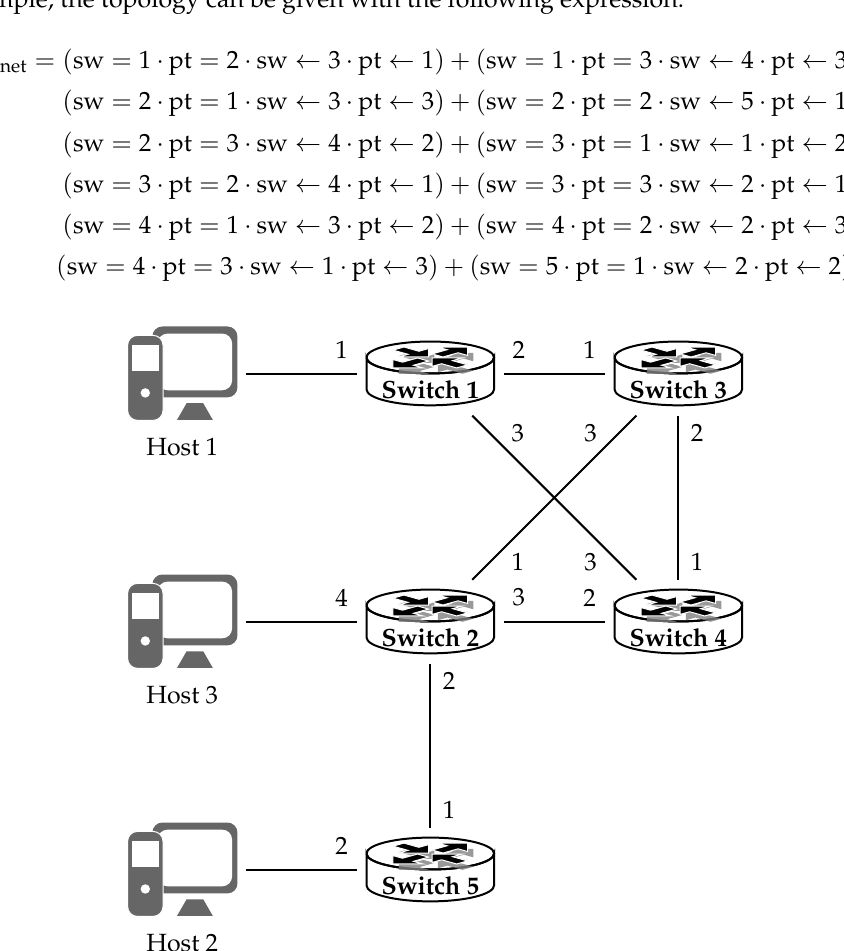
Figure 4. Sample network for demonstrating NetKAT